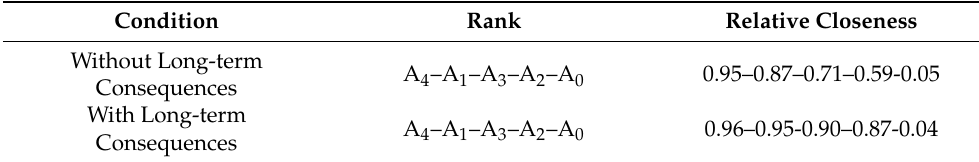
Table 3. Rank preference for the decision matrix of Table